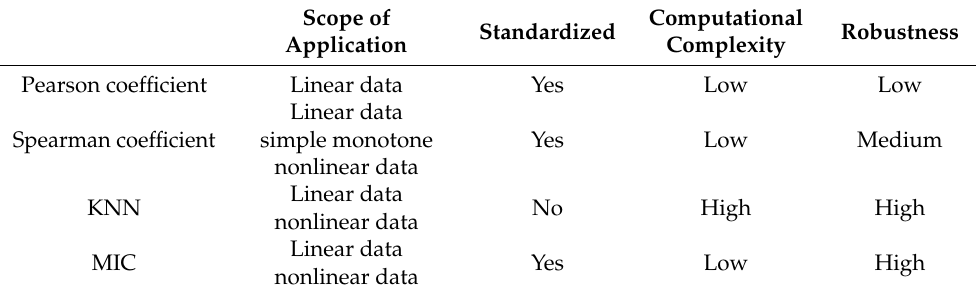
Table 2. Comparison of common